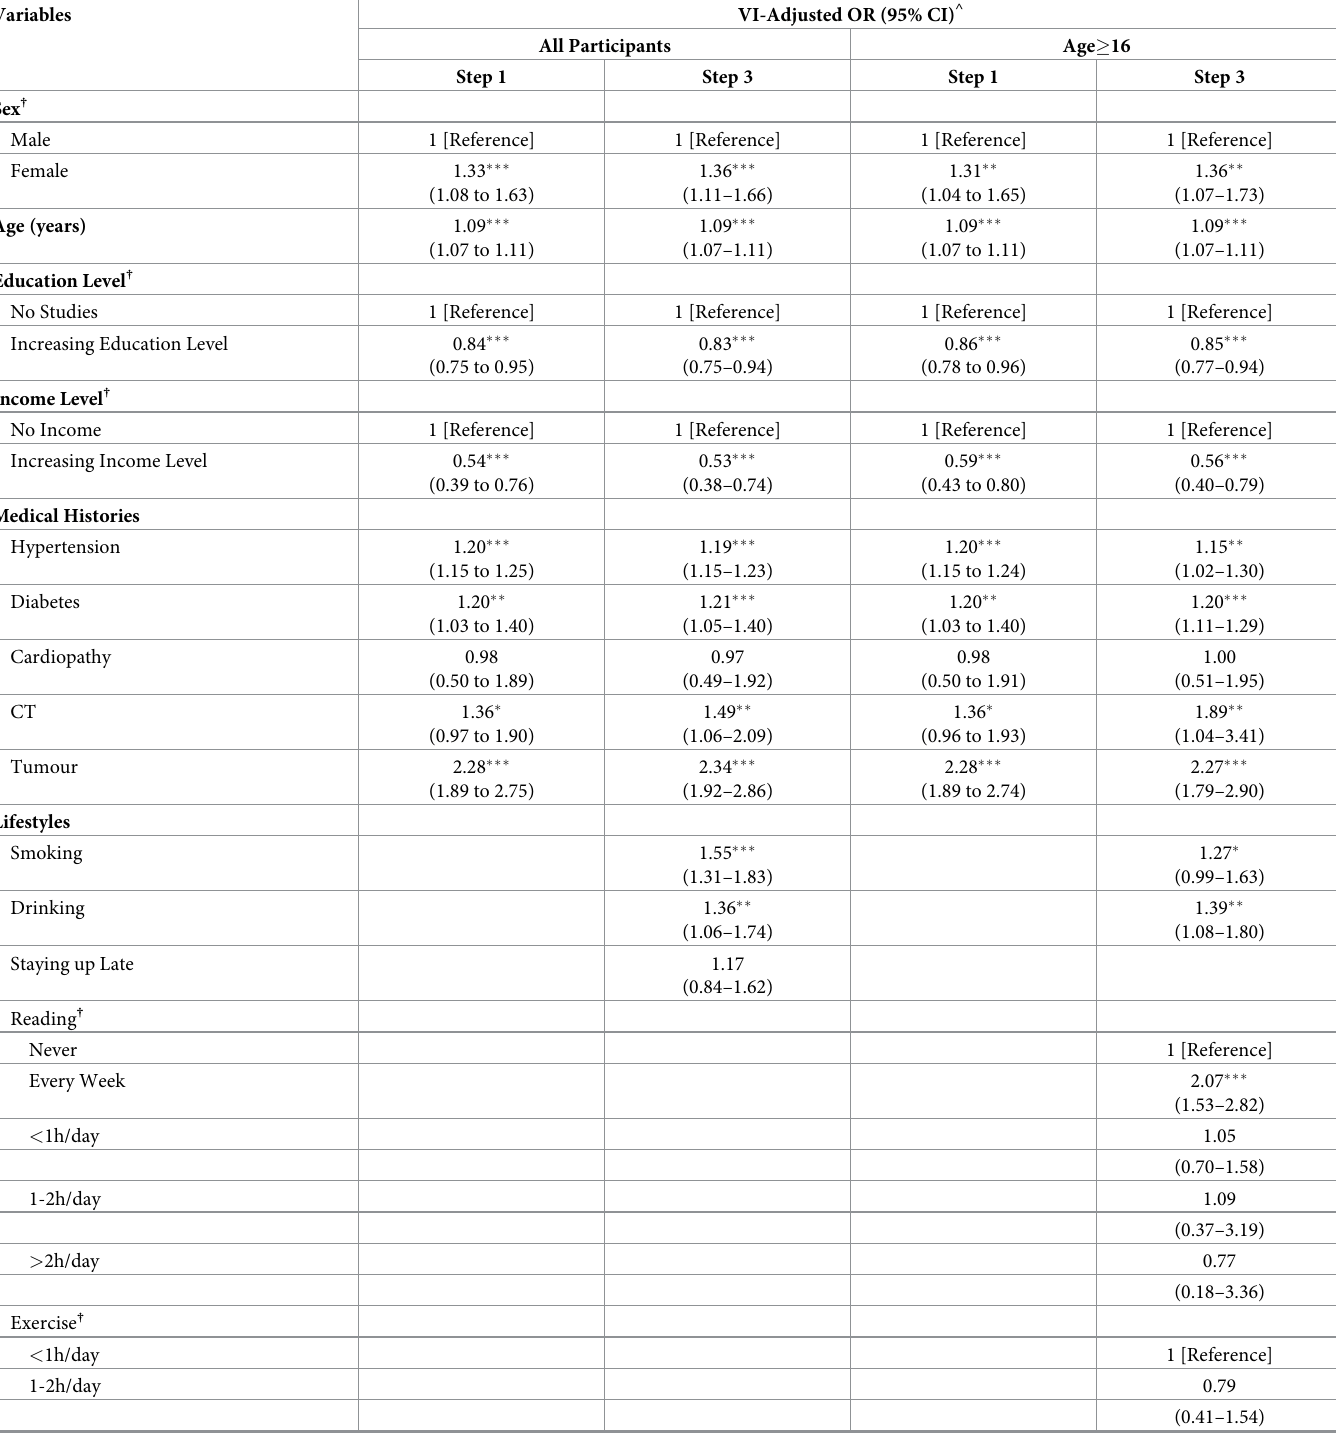
Table 6. Mediating role of lifestyles between socio-economic status and visual